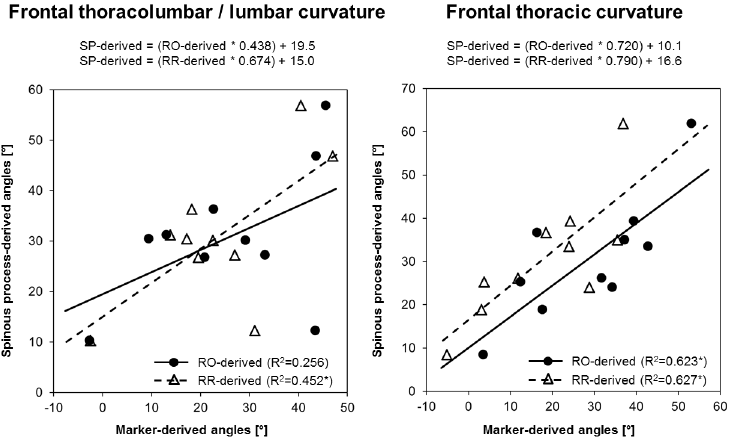
Fig 3. Illustration of the impact of marker placement error on curvature angle estimation. SP: spinous process-derived curvature angles; RO: radio-opaque marker-derived curvature angles; RR: retro-reflective marker-derived curvature angles. The asterisks ( * ) indicate statistical significance at the level p (cid:1)